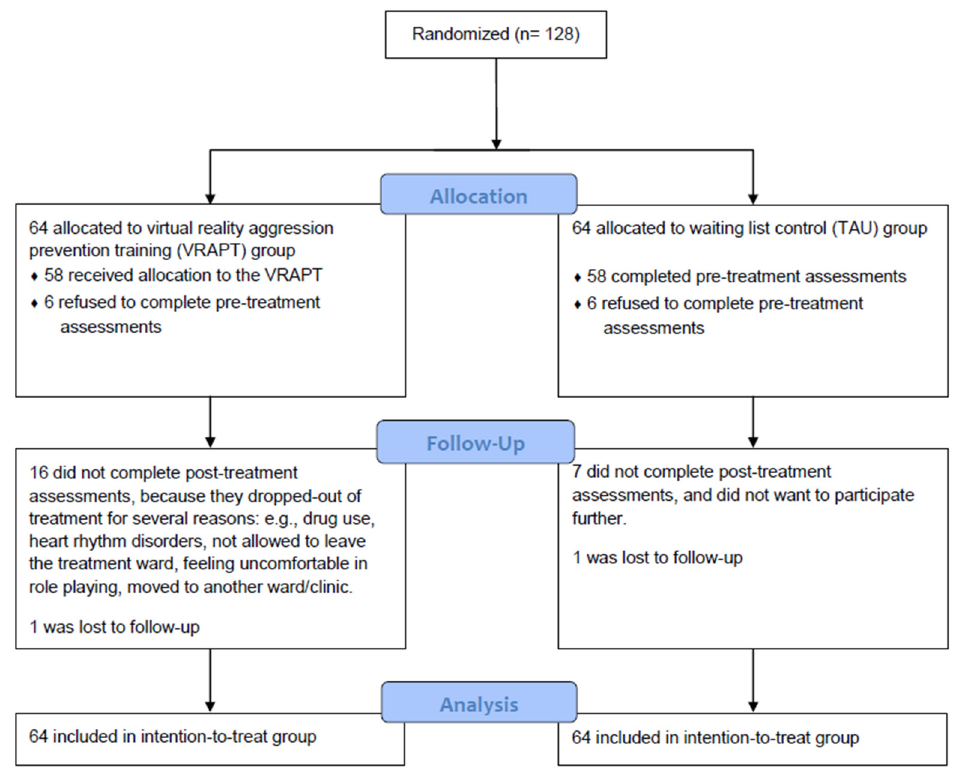
Figure 1. CONSORT flow diagram Virtual Reality Aggression Prevention Training (VRAPT).